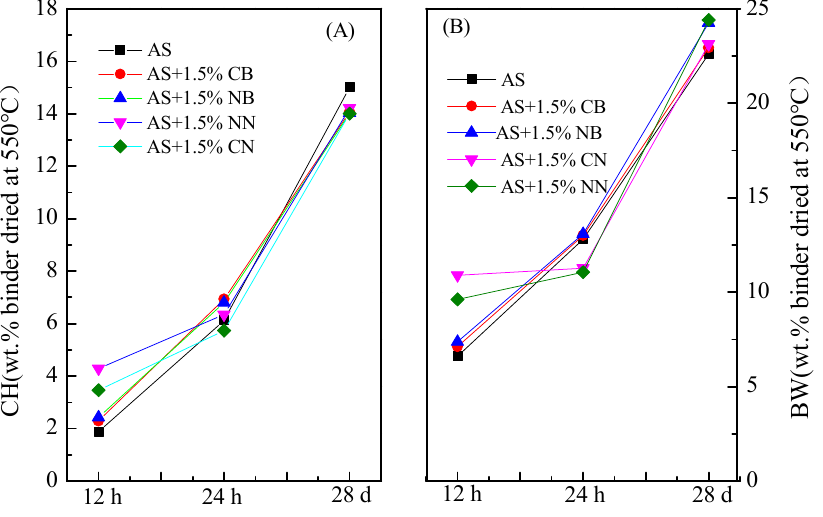
Figure 7. Hydration products of different systems at 10 ◦ C: ( A ) CH (wt%); ( B ) bound water